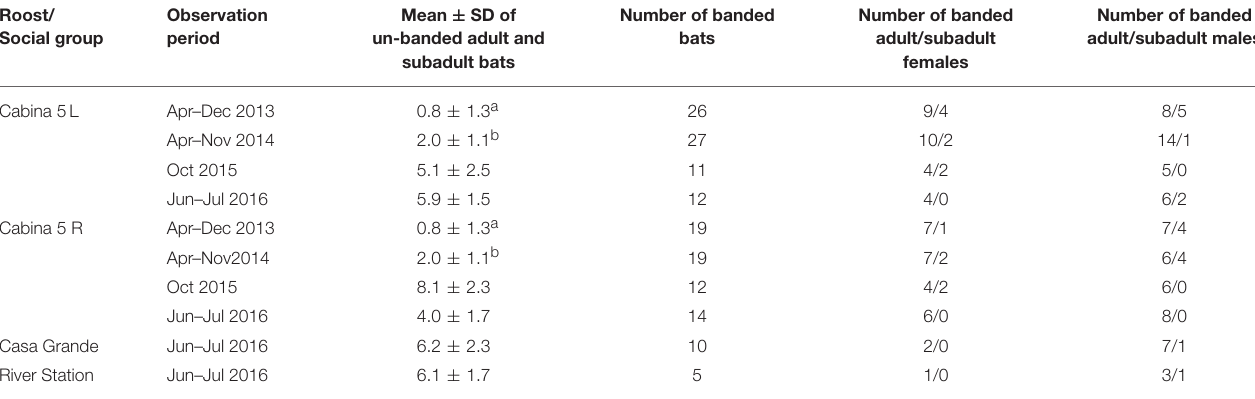
TABLE 1 | Composition of social groups. Roost/ Social group